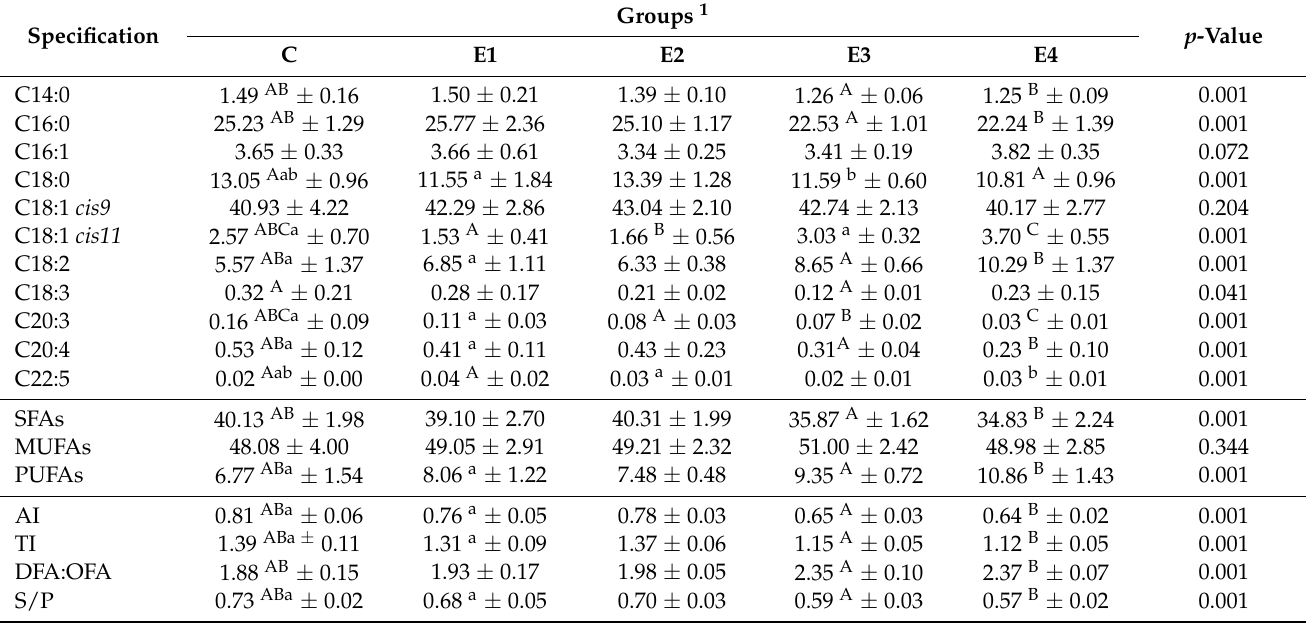
Table 7. Fatty acid composition, contents of groups of fatty acids (g/100 g fat), and values of health-promoting indices, ( x ±